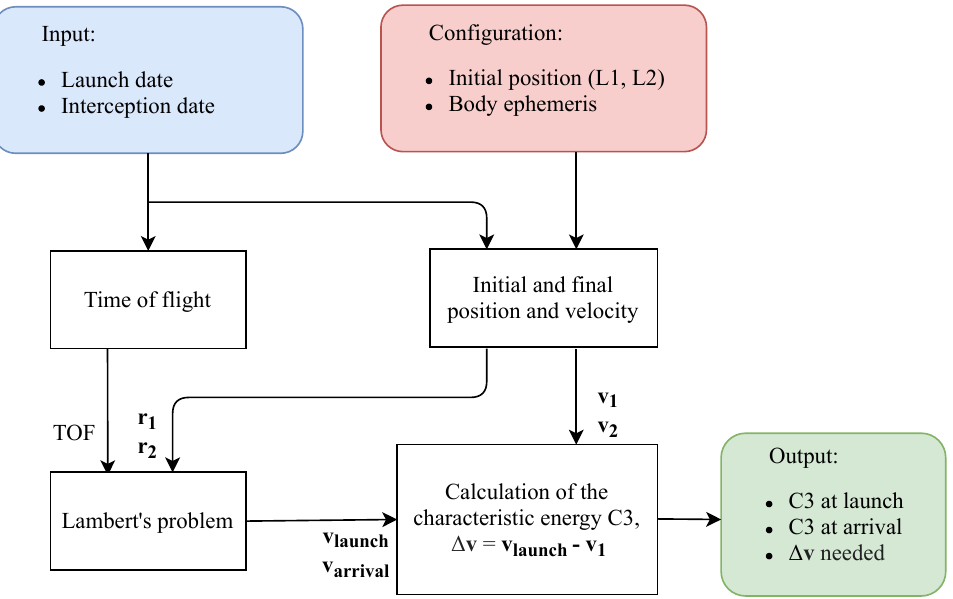
Figure 2. Flowchart of the calculation of direct paths between the starting point and the object to be intercepted, employing Lambert’s problem formulation (adapted from Ishimatsu